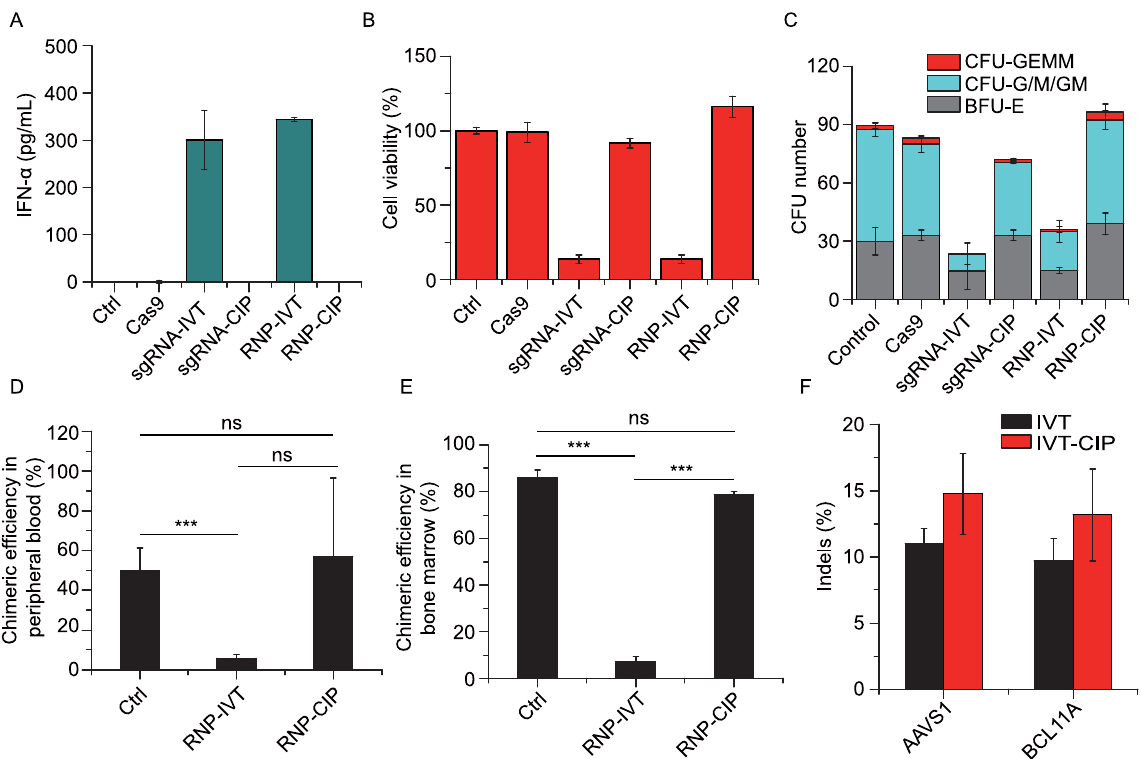
Figure 2. Removing 5 ’ triphosphate of IVT sgRNA by CIP completely rescued the detrimental effects in HSPCs . (A) CIP treatment reduced the production of IFN- α production in HSPCs. (B and C) The cell viability (B) and colony formation ability (C) of HSPCs with CIP treatment were comparable with electroporation mock control. Experiments were performed in cells from two donors, error bars represent SDs for two biological replicates. (D and E) The chimeric ef fi ciencies of HSPCs in NPG mice peripheral blood (D) and bone marrow (E). The chimeric ef fi ciencies were collected 12 weeks post injection. Error bars represent SD for two biological replicates. (F) CIP treatment did not affect the gene editing ef fi ciency of CRISPR-Cas9 system in HSPCs. Indel frequencies were measured by TIDE and bars represent average indel frequencies ±SD, n = 3. Ctrl: control; RNP-CIP: CIP treated BCL11A IVTsgRNA + Cas9 protein; RNP-IVT: BCL11A IVTsgRNA + Cas9 protein. P values were calculated by employing unpaired t -test comparing with indicated groups. *** P <